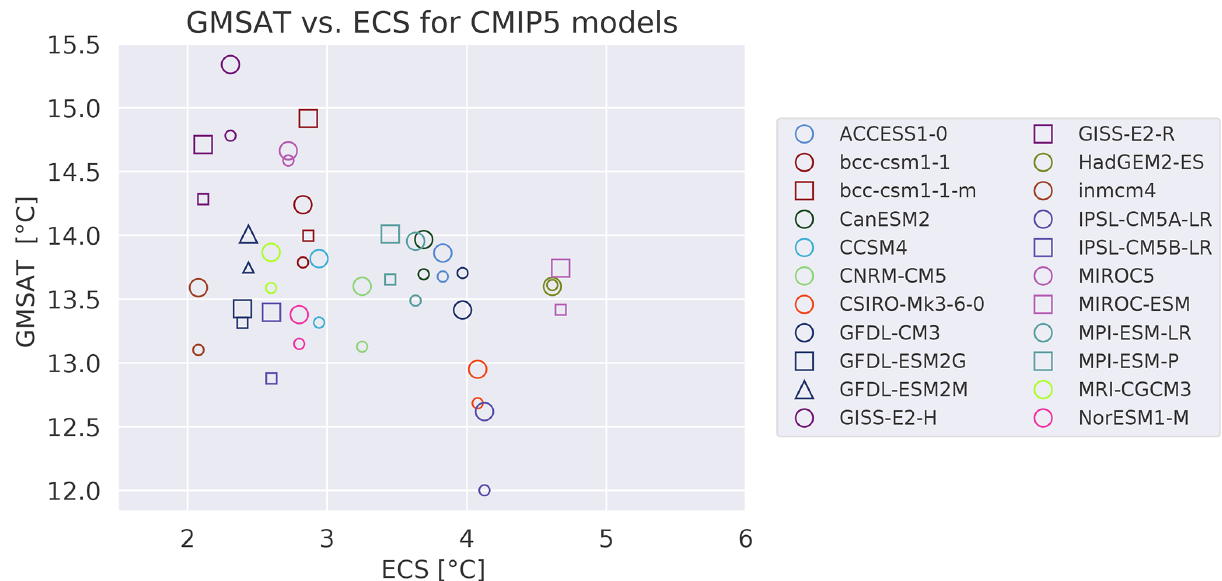
Figure 4. Globally averaged near-surface air temperature (GMSAT) of the historical period of 1961–1990 vs. the ECS for several CMIP5 models. Similar to Fig. 9.42a of Flato et al. (2013) and produced with recipe_flato13ipcc.yml ; see details in Sect. 3.2.